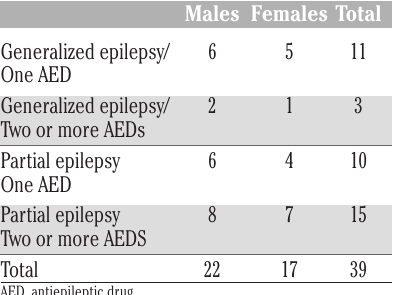
Table 5. Type and relative severity of epilepsy (deduced from the number of AEDs) in relation to